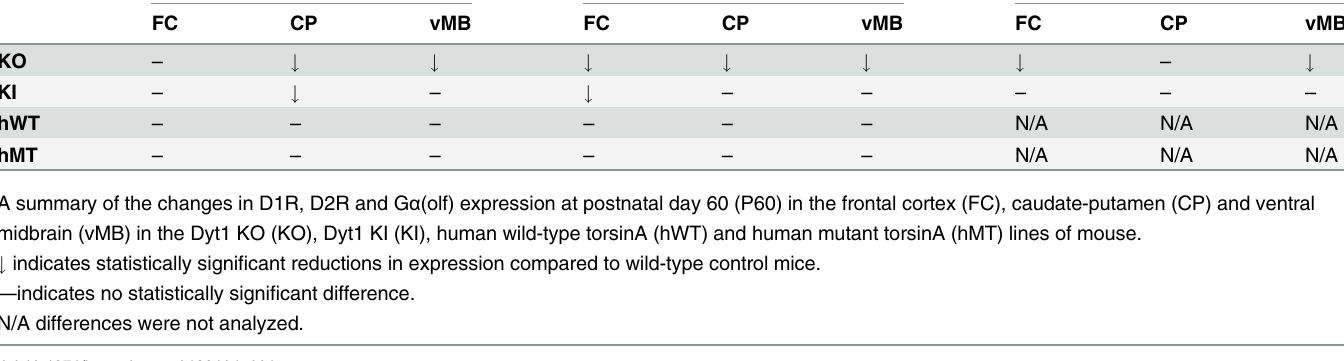
Table 1. A summary of the changes in D1R, D2R and G α (olf) expression at P60. P60